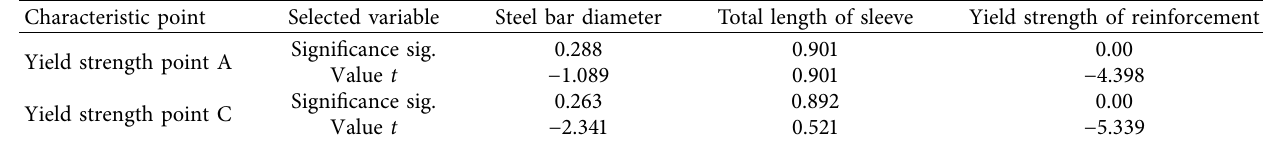
Figure 3: The trilinear constitutive model of the grouted sleeve. Table 2: The characteristic points significance analysis of stress.